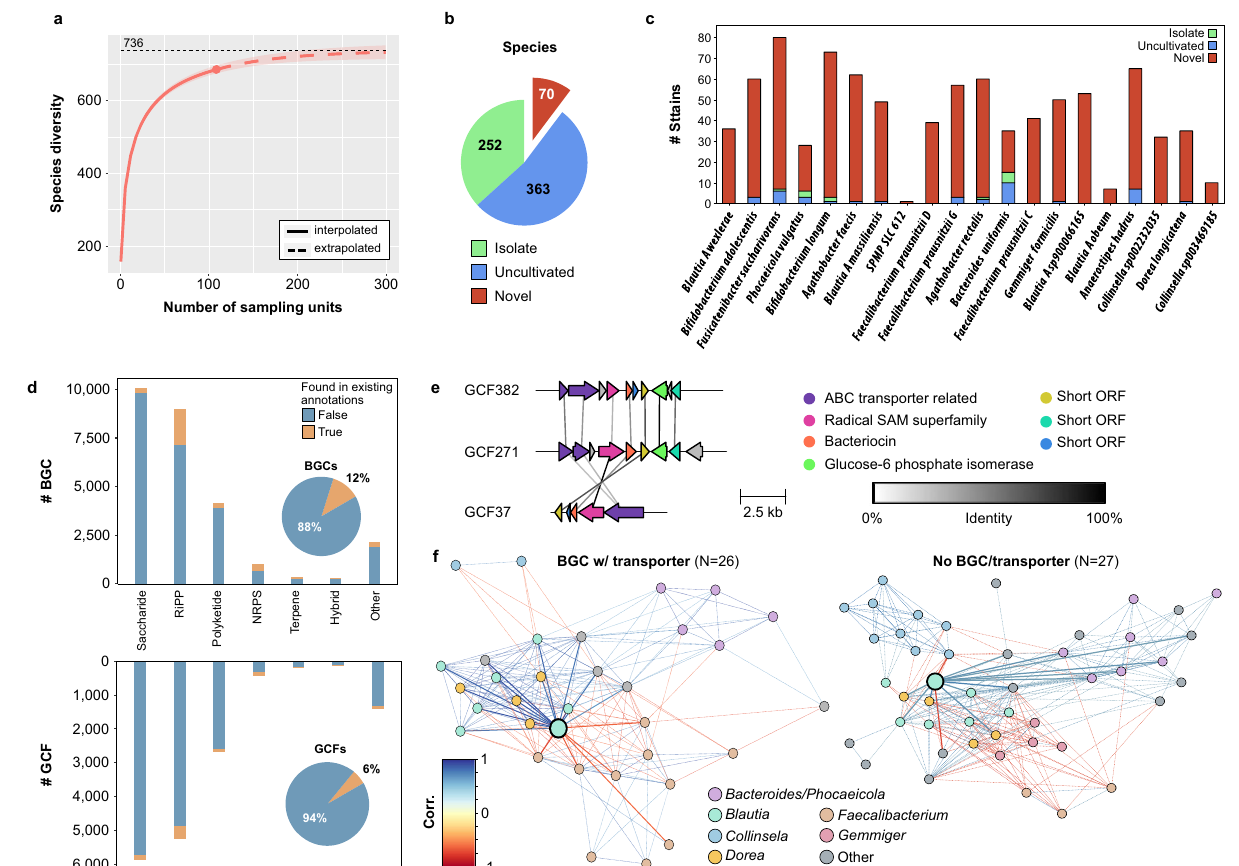
Fig. 2 | Characterization of novel species, strains and gene families in SPMP genomes. a Rarefaction analysis showing that the SPMP database covers a sub- stantial fraction of the species level diversity in its MAGs. Error bands represent con fi dence intervals of 95%. b Pie-chart showing the breakdown of species-level clusters in SPMP that have an isolate genome, only have MAGs ( uncultivated ) and are novel comparedtogenomesinpublicdatabases(UHGG,GTDB,SGB). c Stacked barcharts showing the number of SPMP strains that have an isolate genome, only have MAGs ( uncultivated ), and are novel compared to all UHGG genomes (>200,000, <99% ANI). The species shown are the top 20 in terms of median relative abundance in SPMP (most abundant on the left). d Stacked barcharts showing the number of BGCs(top)and GCFs(bottom) indifferent productclasses